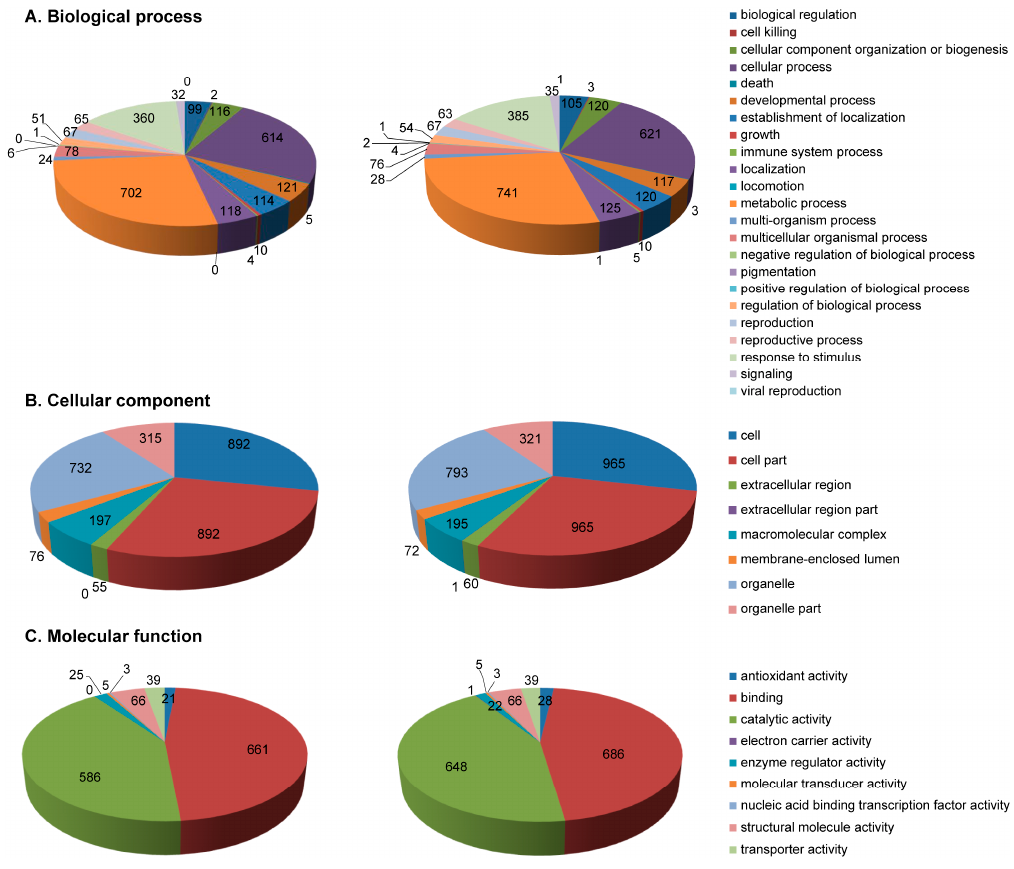
Figure 3. Functional classification of the identified proteins at all developmental stages for both endosperm and pericarp according to: GO annotations in biological process ( A ); molecular function ( B ); and cellular component ( C ). Left , pericarp; right , endosperm.